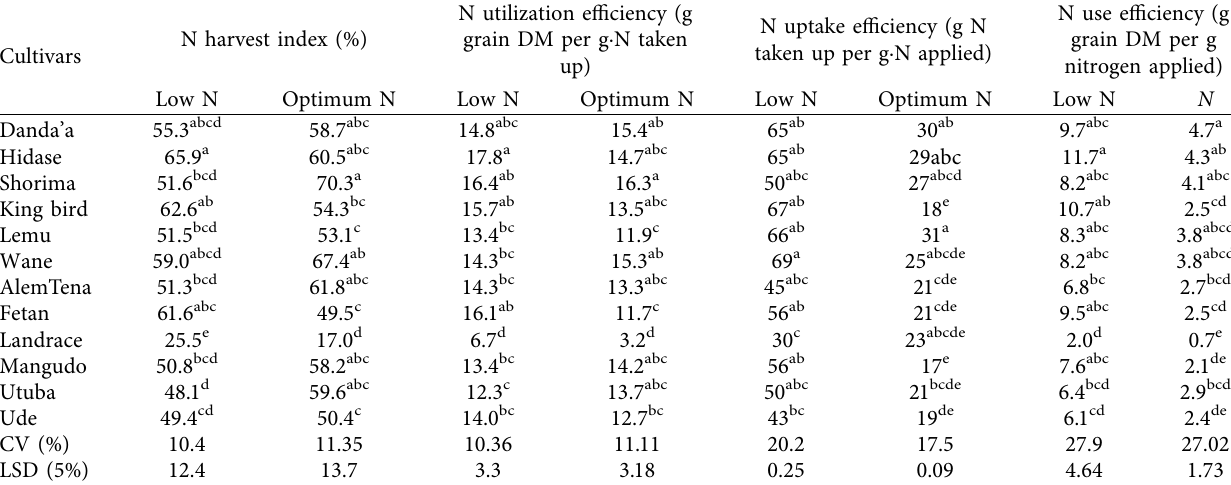
Table 4: N harvest index, N utilization, N uptake, and N use efficiencies of wheat cultivars. N harvest index (%) Cultivars